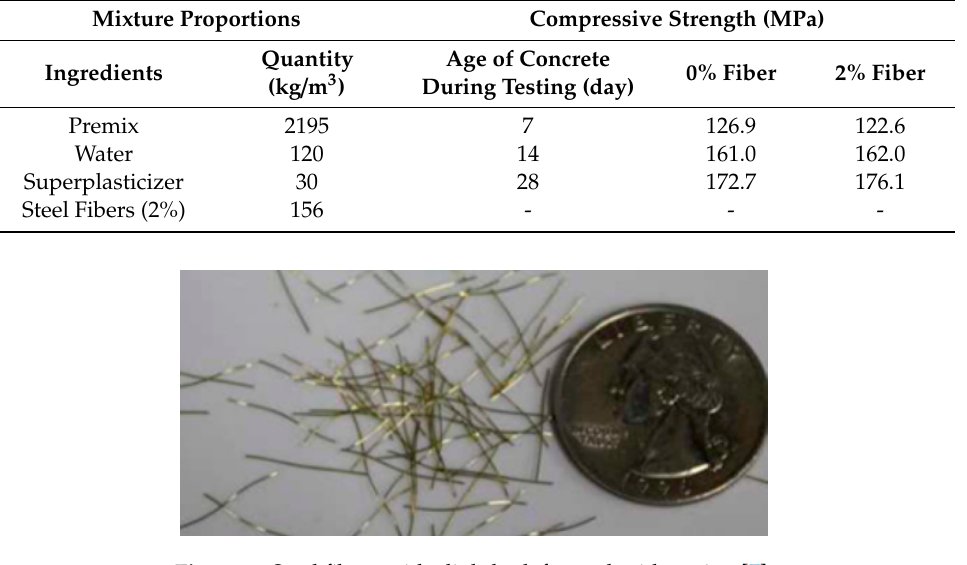
Figure 5. Steel fibers with slightly deformed mid-section [7].